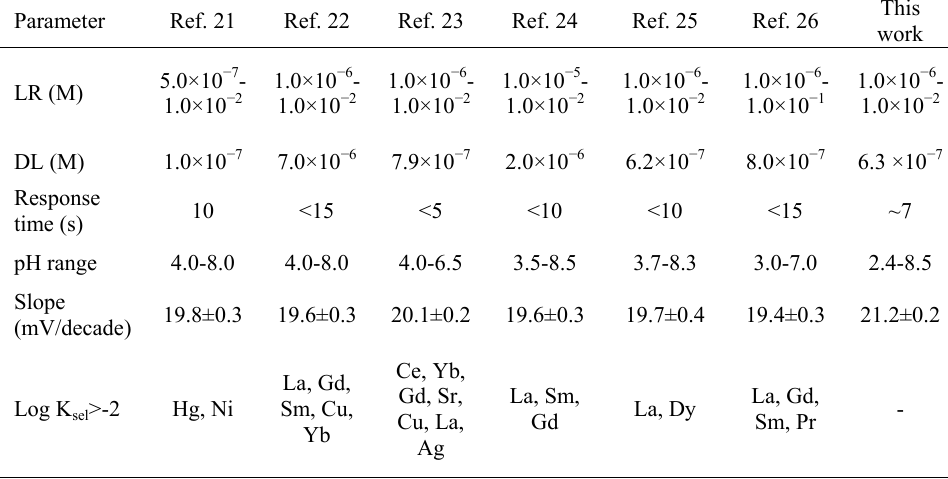
Table 3. Comparison of different Nd 3+ electrodes.